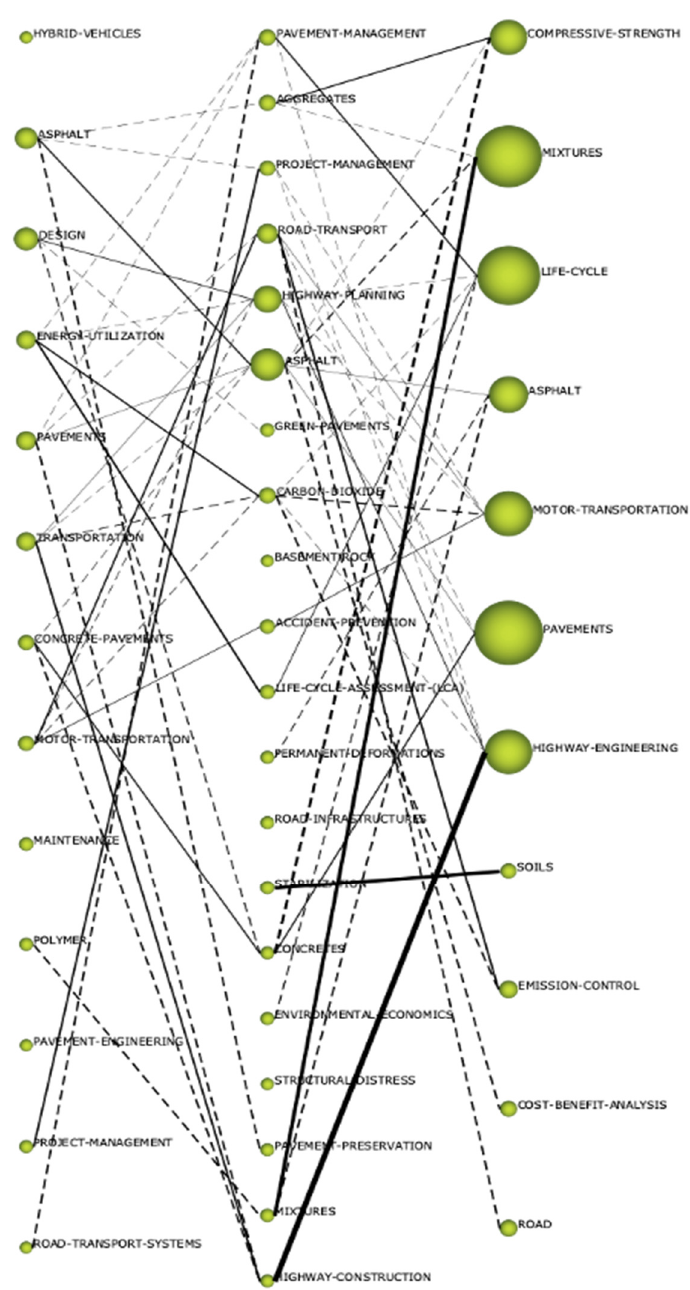
Figure 8. Thematic evolution map of the research field in terms of number of documents.